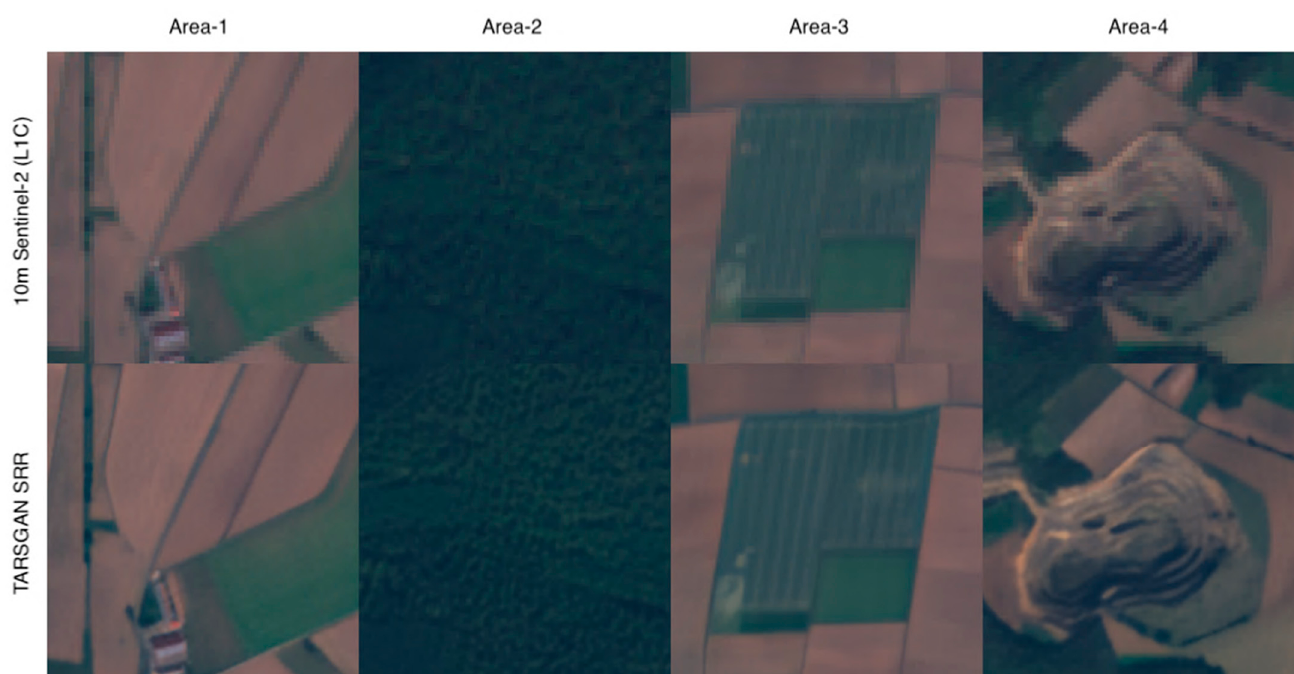
Figure 9. Cropped examples (625 m × 625 m) of the 10 m/pixel Sentinel-2 “true” colour images (L1C) and TARSGAN SRR result over Hainich, Germany (Site-3). Please refer to supplementary material for full-size SRR (produced from Sentinel-2